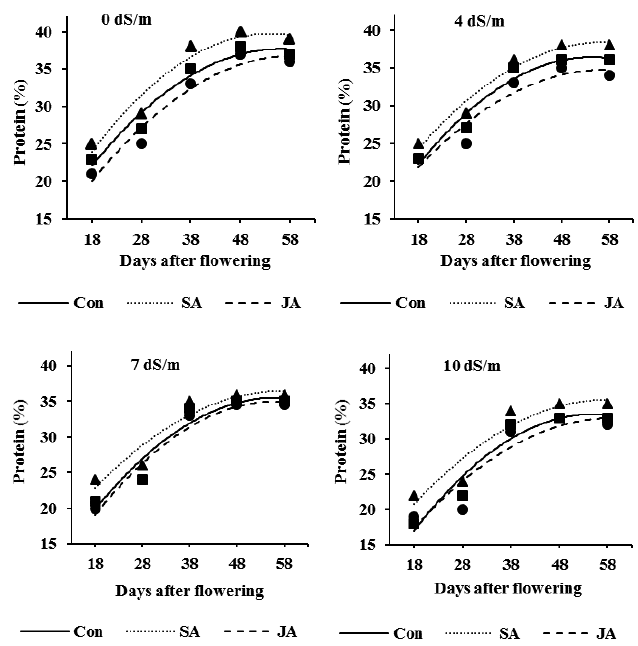
Fig. 3: Changes in protein percentage of soybean (M7 cultivar) seeds in response to salinity and hormonal applications